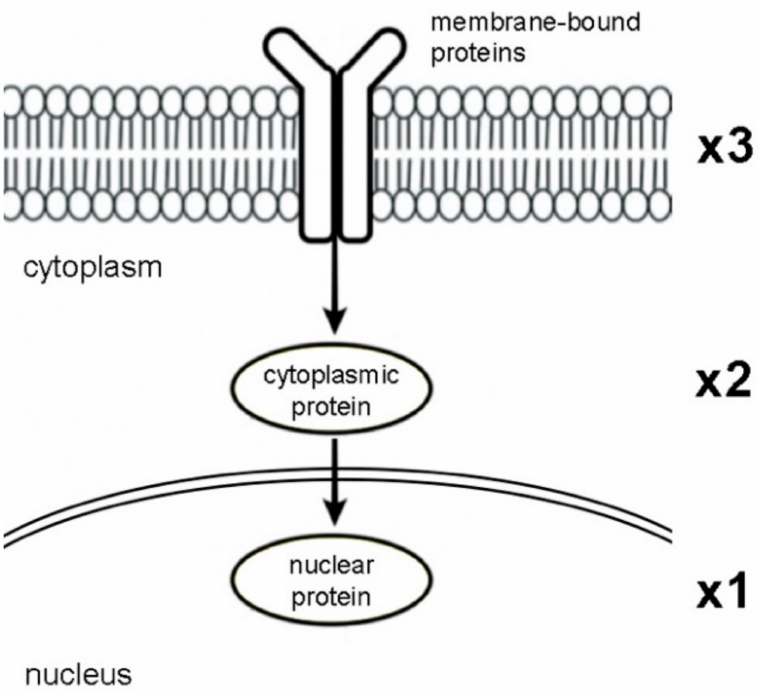
Figure 2. Weighting score of ligand-accessibility of the protein. The score 3, 2 and 1 represented transmembrane, cytoplasmic and nuclear proteins,